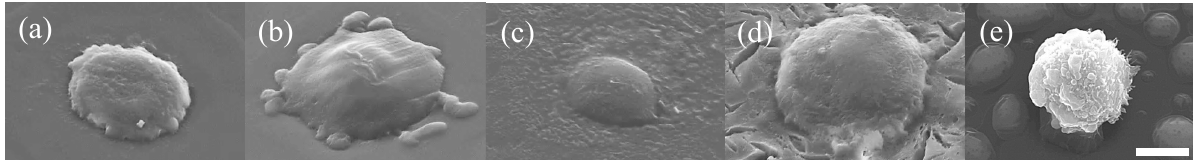
Figure 5. L929 adhesion onto t-hm-AlGltn films after being cultured for 5 min. Morphology of L929 cells on t-hm-AlGltn films (( a ) t-AlGltn; ( b ) t-42HxAlGltn; ( c ) t-38DecAlGltn; ( d ) t-44SteAlGltn and ( e ) tissue culture plate). Scale bar: 5 µm.